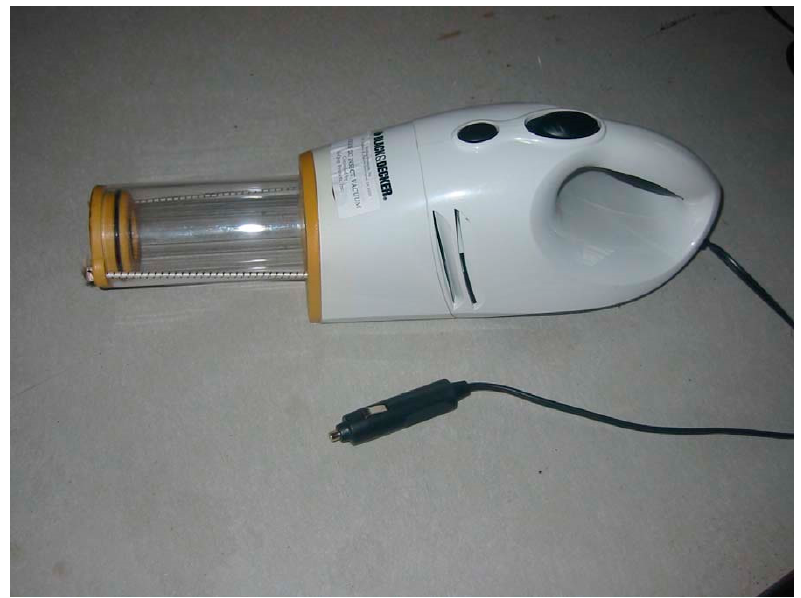
Figure 4. Hand-held portable vacuum aspirator used to collect mosquitoes that landed on the